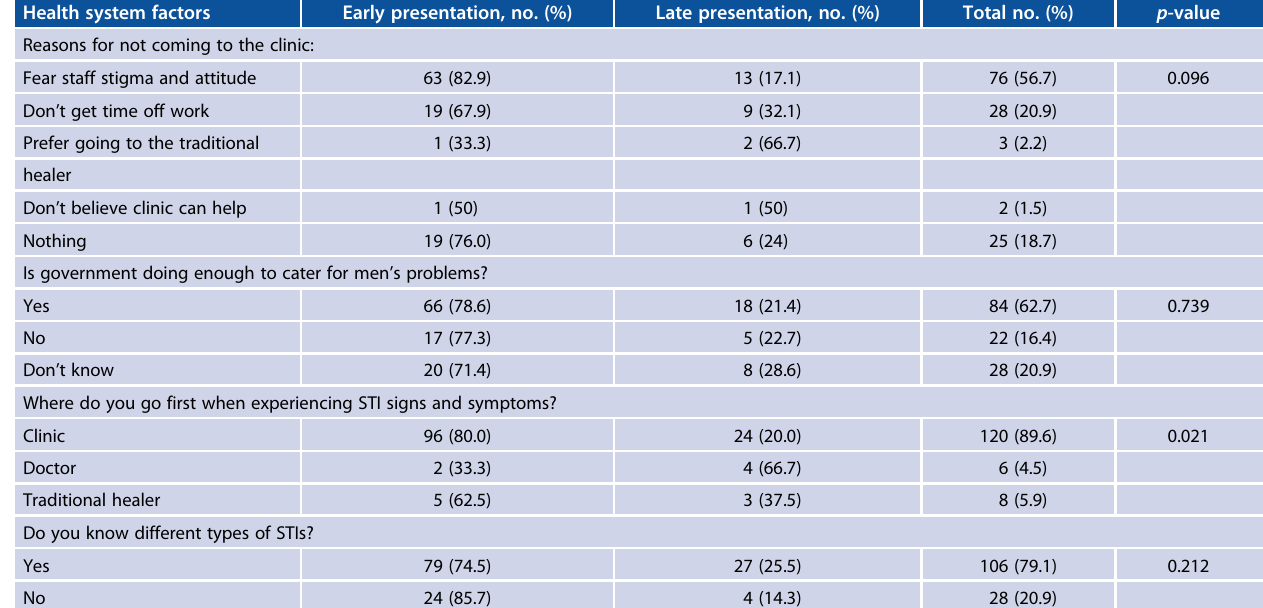
Table 3: Health system factors associated with men ’ s delayed health seeking behaviour, showing the proportions in the early presentation ( n = 103; 76.9%) vs. late presentation ( n = 31; 23.1%) groups (number, %) Health system